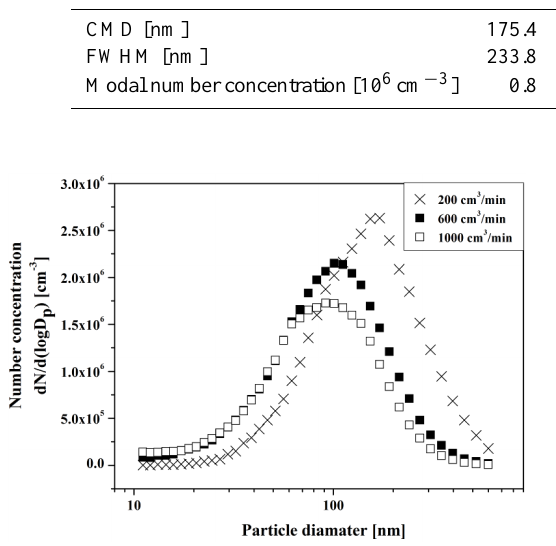
Figure 5. Number size distribution of the generated carbonaceous particles at three different volumetric flow rates of nitrogen purging gas at 2Jcm − 2 fluence.